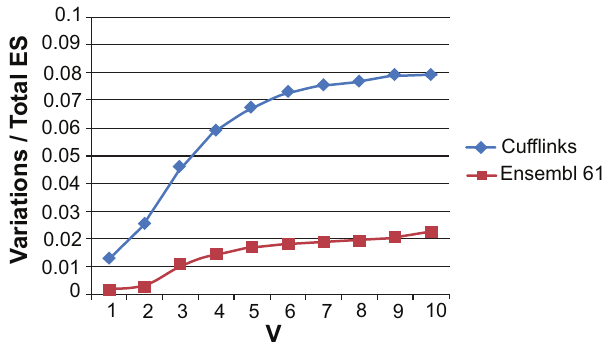
Figure S 6 . Number of event variations due to small differences in exon and intron boundaries as a fraction of the total number of events, with varying cutoffs for the allowable difference (V bp). Values shown are for exon skipping (ES) events derived from